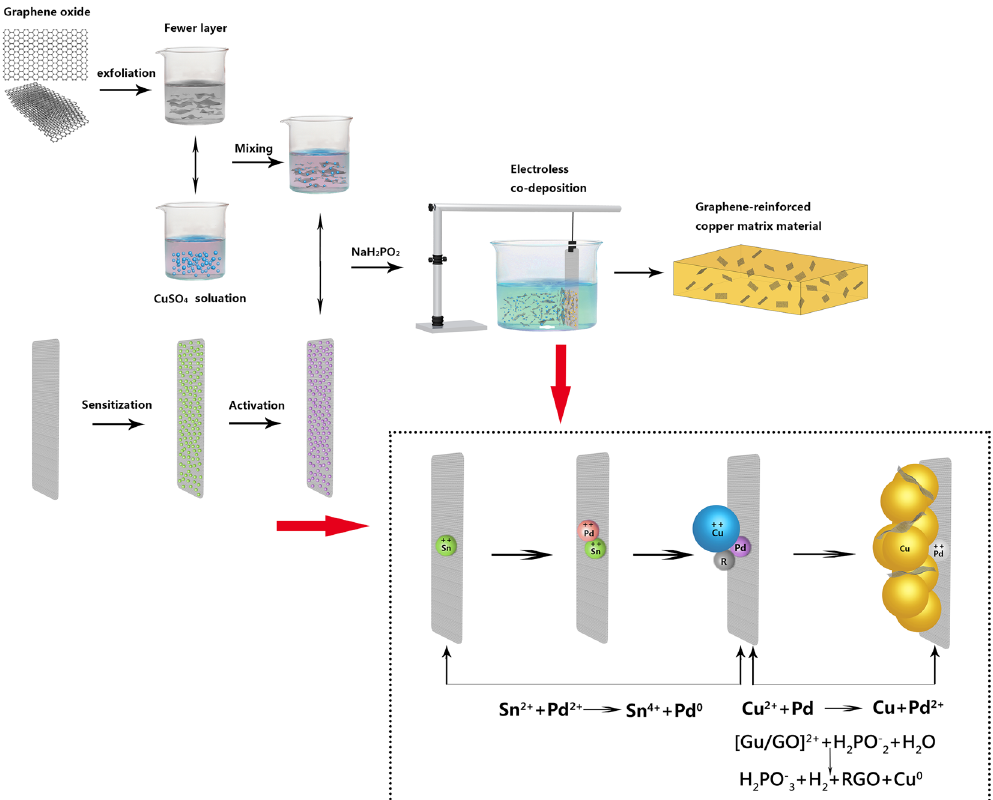
Figure 1. Schematic diagram of the electroless co-deposition technique for preparing graphene-reinforced copper